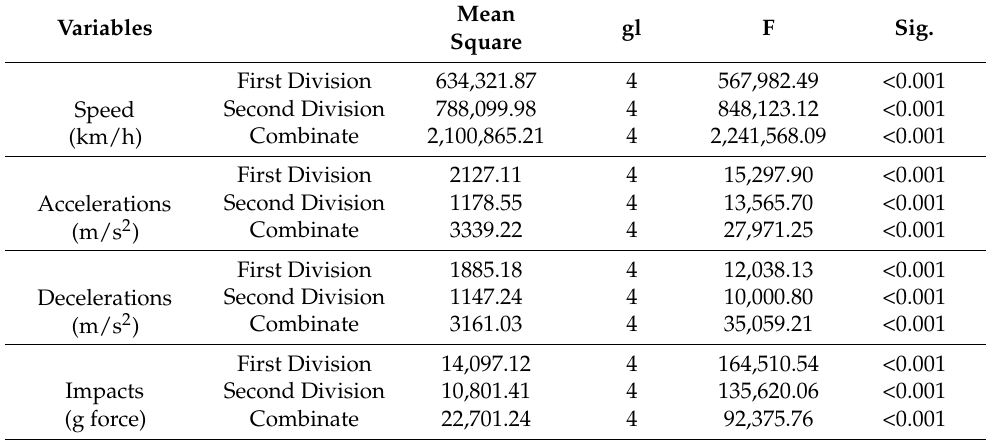
Table 2. Quality result of the k-means